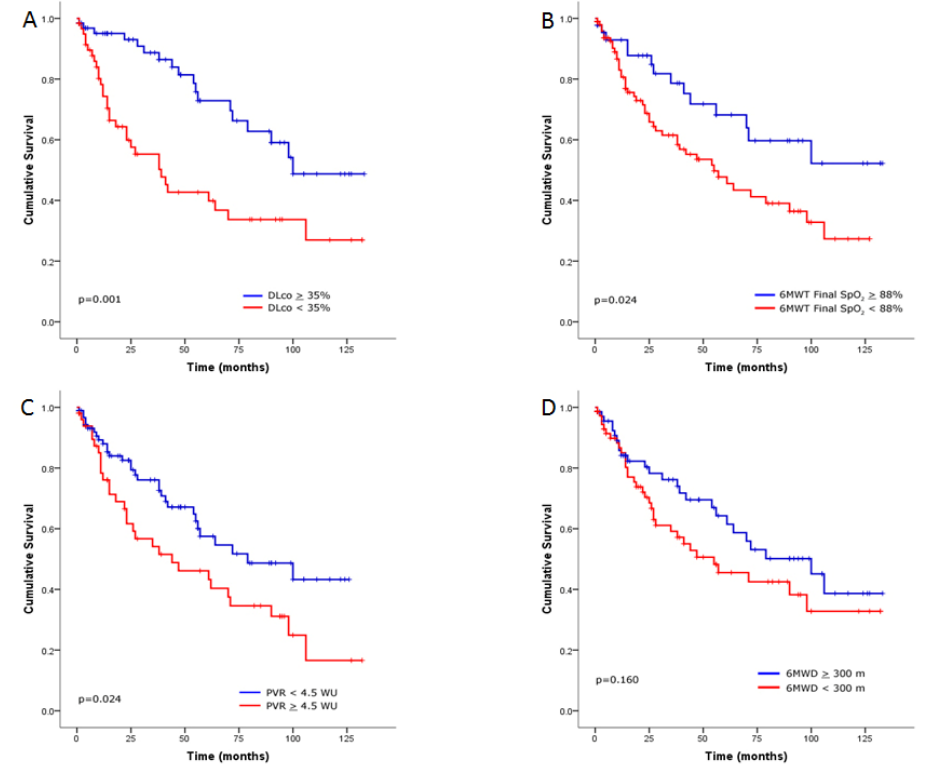
Figure 3. Kaplan–Meier survival estimates for the relationship with ( A ) diffusion capacity of the lung for carbon monoxide (DLco) at a threshold of 35% predicted, ( B ) six-minute walk test (6MWT) final oxygen saturation by pulse oximetry (SpO 2 ) at a threshold of 88%, ( C ) pulmonary vascular resistance (PVR) ≥ 4.5 Wood units (WU) and ( D ) 6 min walk distance (6MWD) at a threshold of 300 m in interstitial lung disease patients with pulmonary